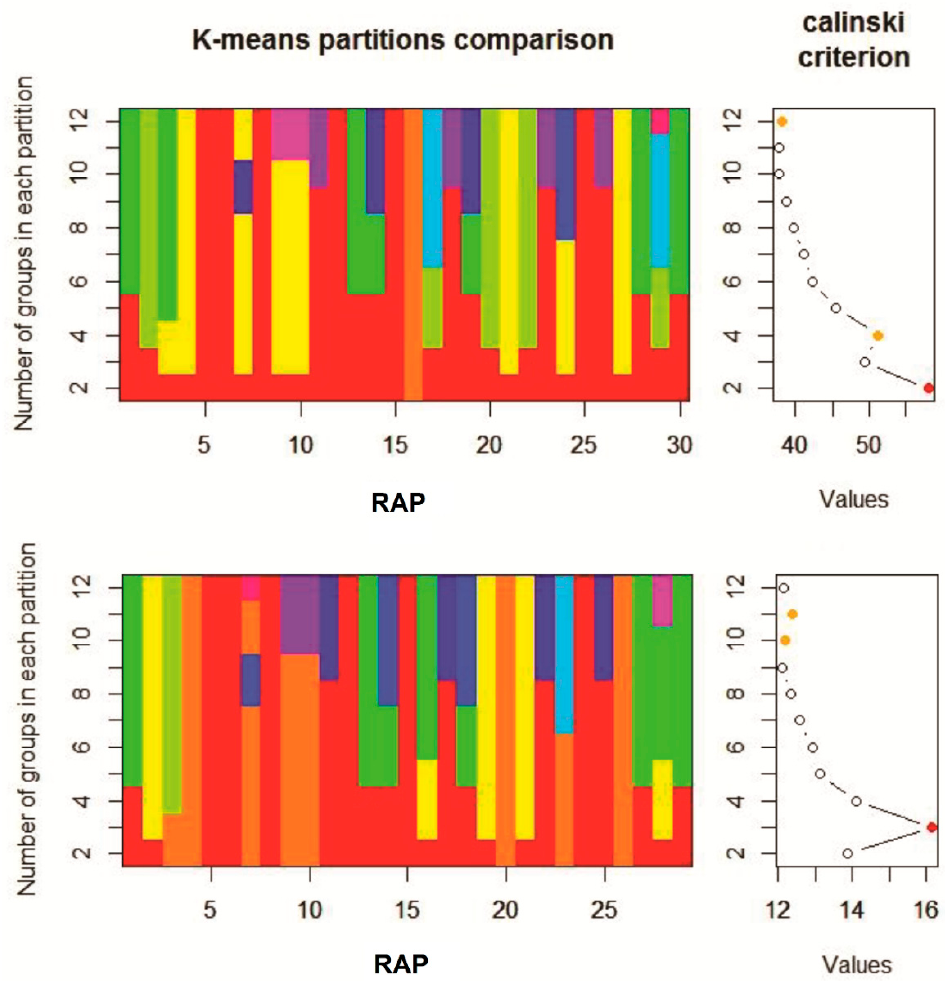
Figure 3. Results of the two K-means clustering applied with the Calinski–Harabasz criterion (CHC). The CHC indicated that the 30 RAP could be clustered into two groups (1 species in one, 29 in the second) in a first analysis (top chart), also marked as a red point on the linear plot of CHC values above on the right. Second K-means clustering with 29 species, shown in the bottom chart). The CHC indicated that the 29 RAP could be clustered into three groups, (red point in the linear plot of CHC values below, equivalent to the first orange point in CHC plot shown above). Colors within each of the columns of the figures on the left (30 above and 29 below) are groups of RAP in the K-means calculations.